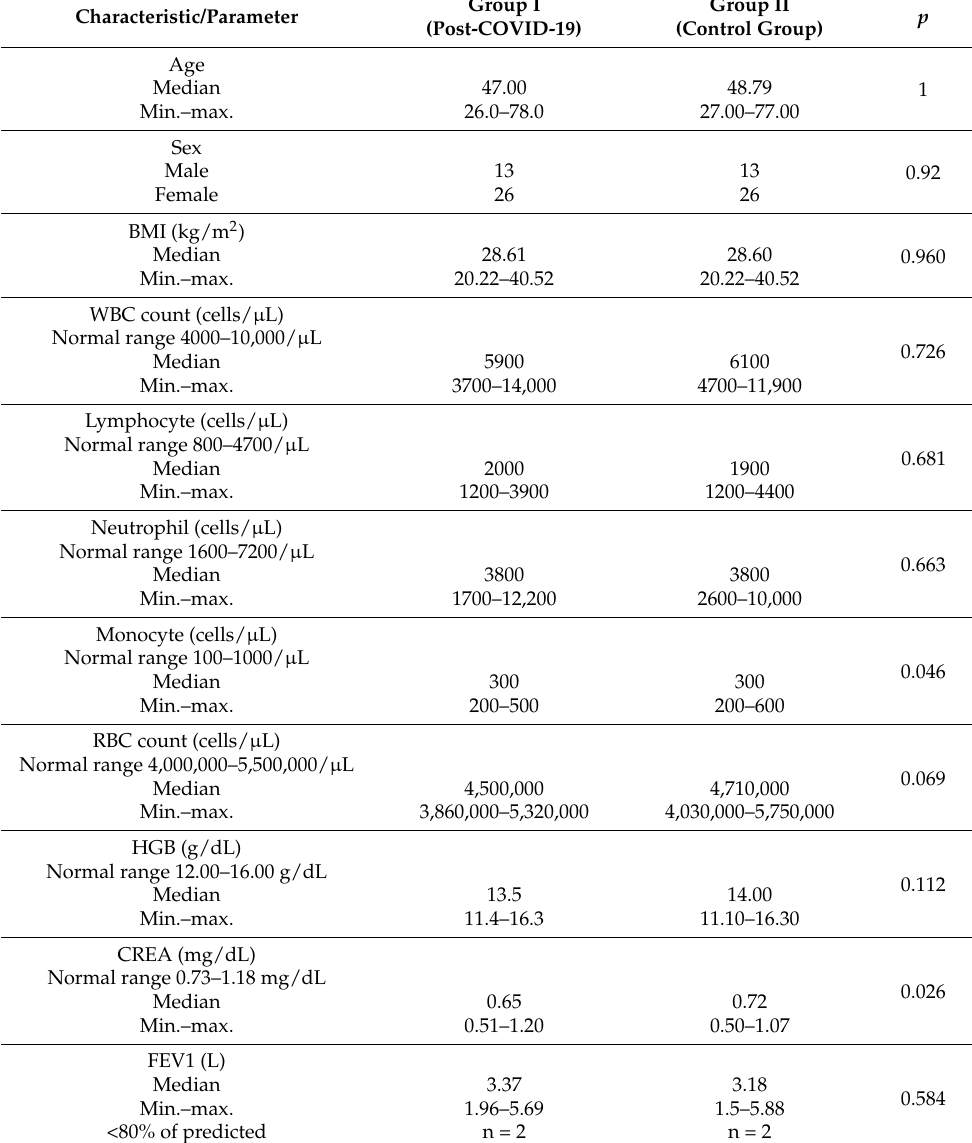
Table 1. Demographic and clinical characteristics, the median, and extreme and statistical significance of laboratory tests and pulmonary function tests in patients 6 months after COVID-19 (post-COVID-19) and the control group